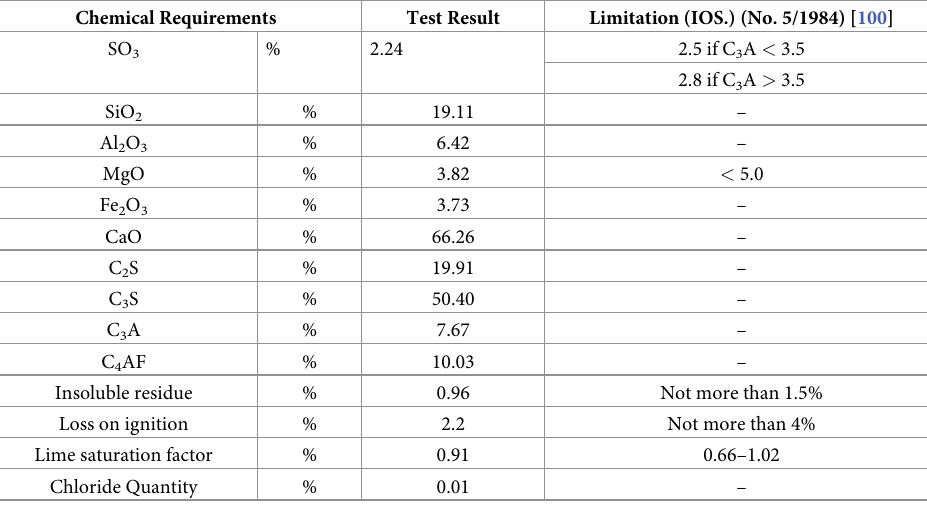
Table 1. The chemical characteristics of ordinary Portland cement �